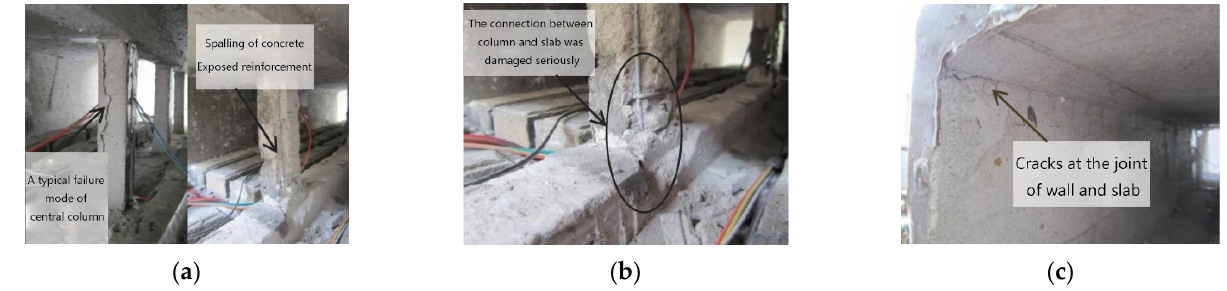
Figure 11. Earthquake damage phenomenon in the shaking ‐ table test: ( a ) failure mode of the join between central column and slab, ( b ) failure mode of the joint between side wall and slab, ( c ) failure mode of the joint between side wall and slab.